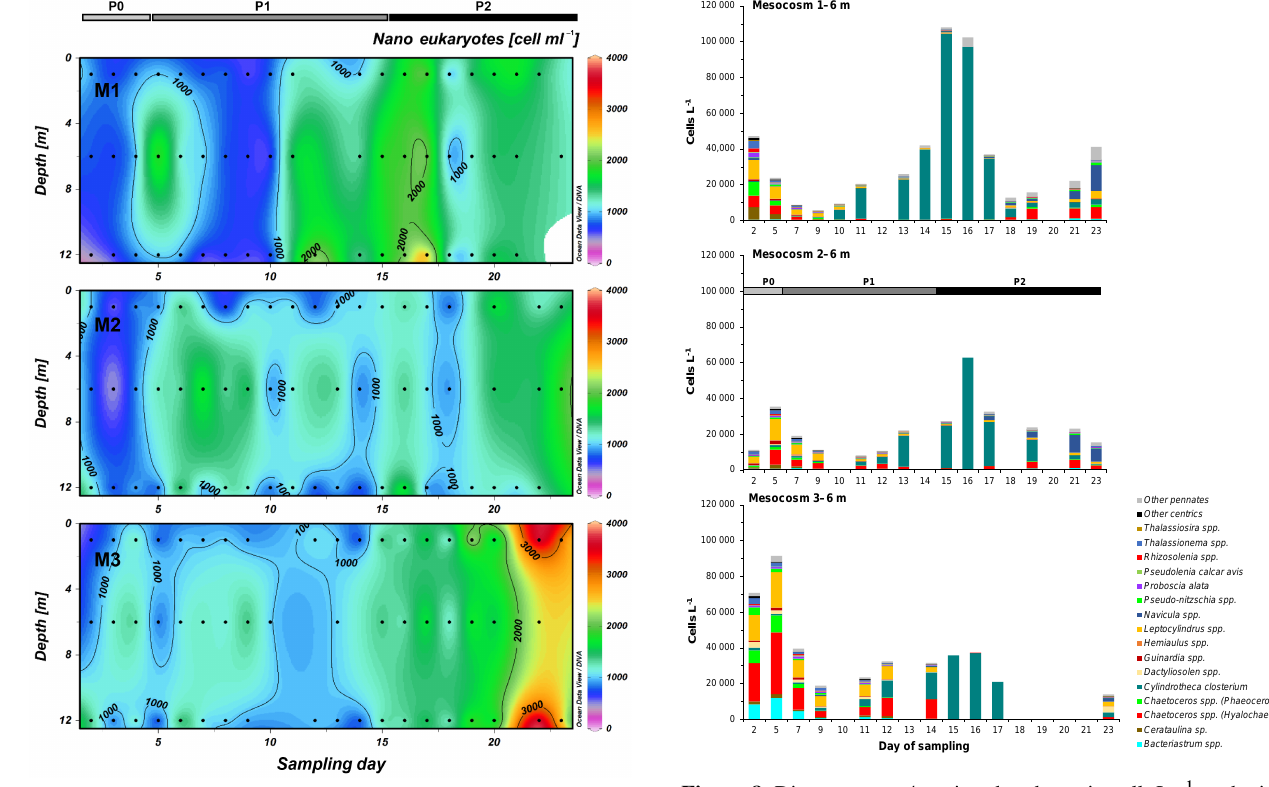
Figure 7. Nanoeukaryotes in cellsmL − 1 at each of the three depths (1, 6 and 12m) inside each mesocosm (M1, M2 and M3).